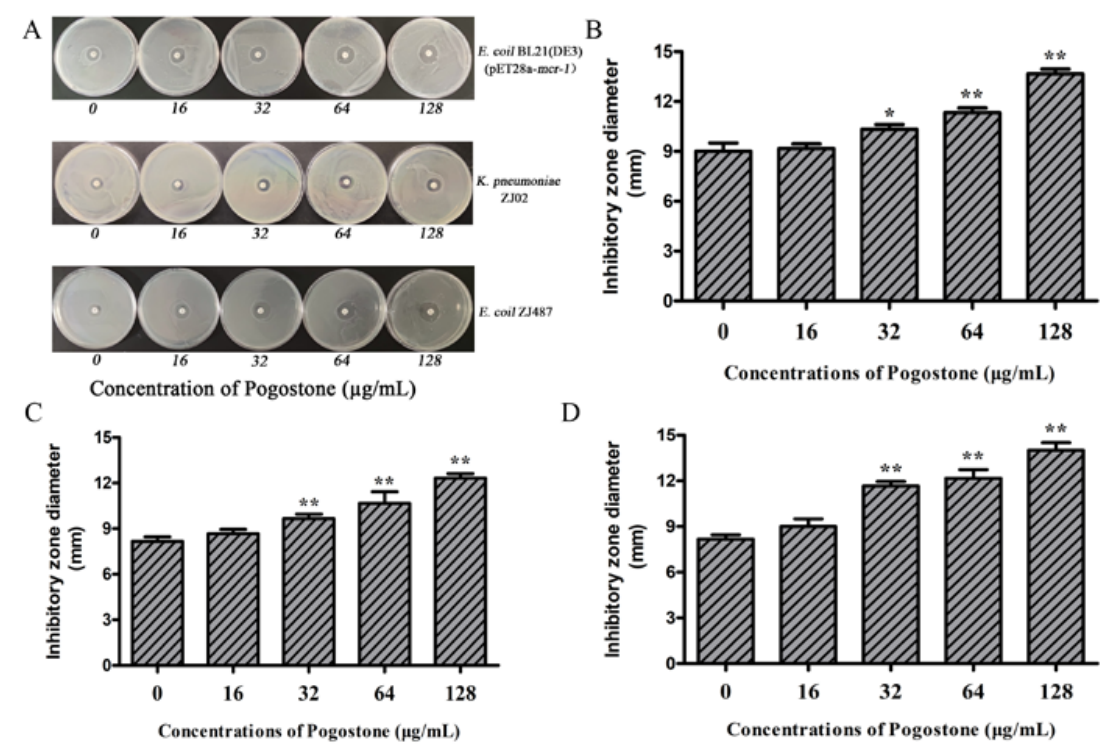
Figure 2. Zone of inhibition test of colistin combined with pogostone ( A – D ). Zones of inhibition surrounding the disks of colistin supplemented with 0, 16–128 µg/mL pogostone. Values represent the averages of three independent experiments. ** p < 0.01; * p < 0.05.